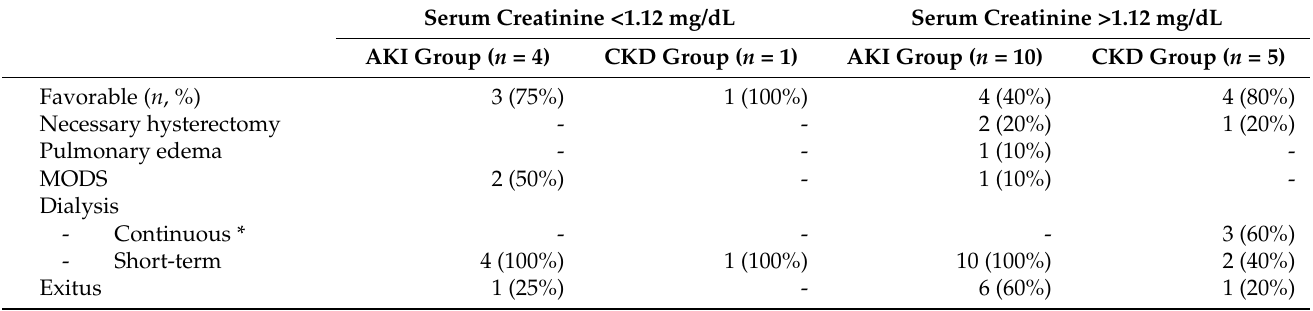
Table 3. Maternal outcomes in dialysis patients related to the serum creatinine threshold value.